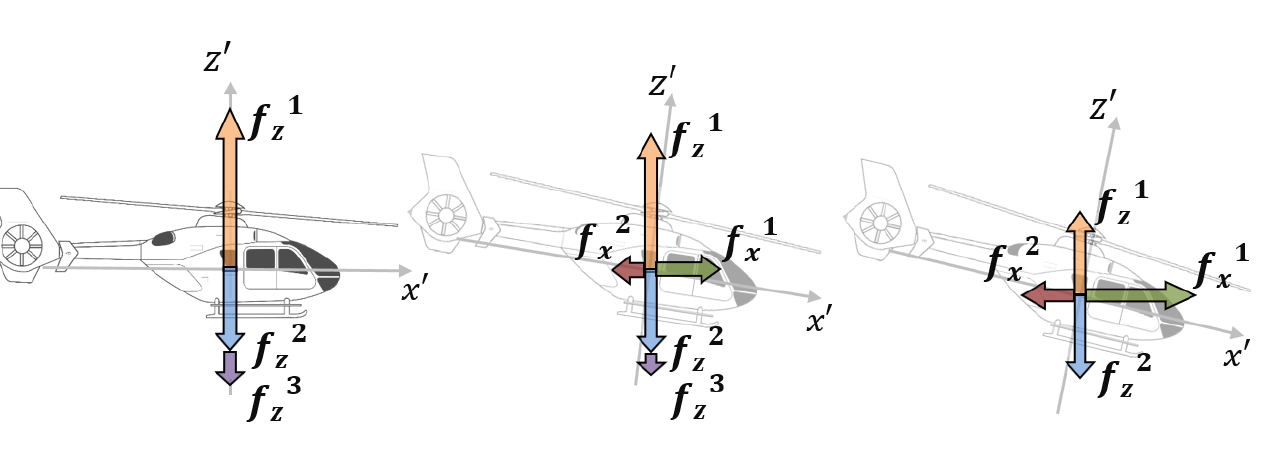
Figure 9. Friction terms encountered by a flying helicopter in correspondence of an increasing horizontal speed. The variables are defined as f 1 z = e (cid:62) z ϕ , f 2 z = M H ¯ g , f 3 z = e (cid:62) z ˙ p β v , f 1 x = e (cid:62) x ϕ , f 2 x = e (cid:62) x ˙ p β h .